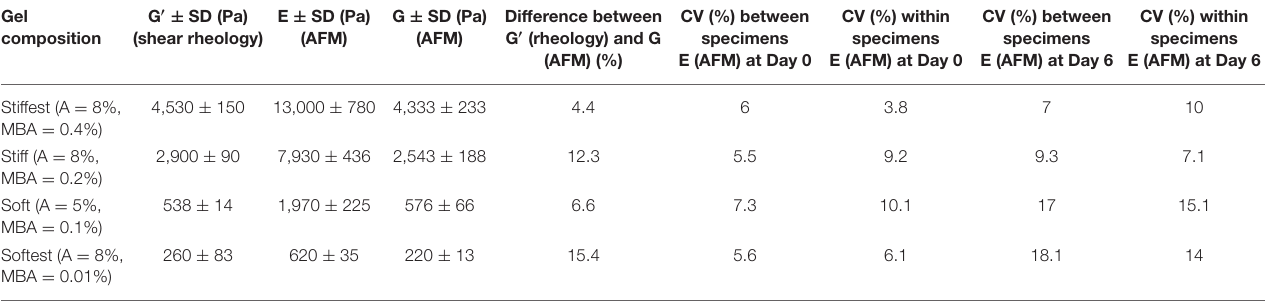
TABLE 1 | Summary of global ( in situ bulk shear rheology) and local (AFM) elastic properties obtained for four different gel compositions (A, acrylamide; MBA, N ′ N ′ methylene bis acrylamide; concentrations are expressed as grams of solute per 100mL of mixture, %w/v).